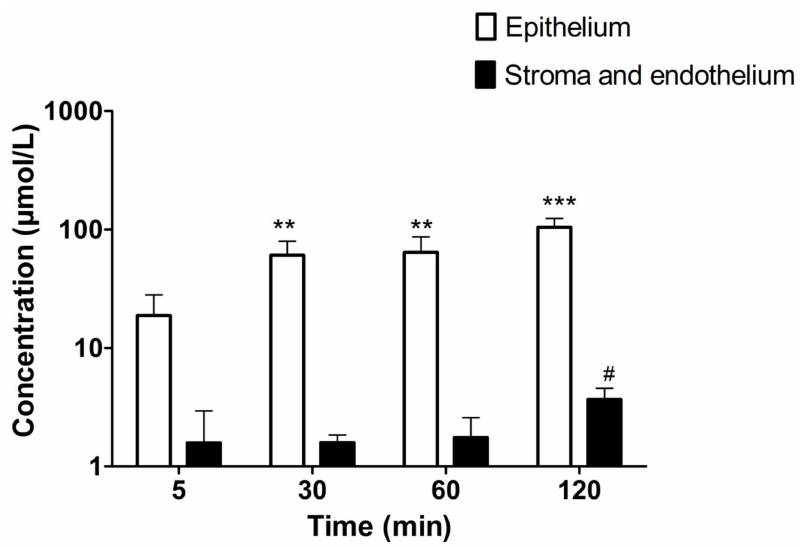
Figure 1. The concentrations of UAMC-3203 (50 µ M) in corneal epithelium and stroma with endothe- lium at various time points. Statistical analysis was performed by t -test: ** p < 0.01 and *** p < 0.001 for concentration µ mol/L epithelium (compared to that at 5 min), and # p < 0.05 for concentration µ mol/L and endothelium (compared to that at 5 min). The results are expressed as mean ± standard deviation, n =